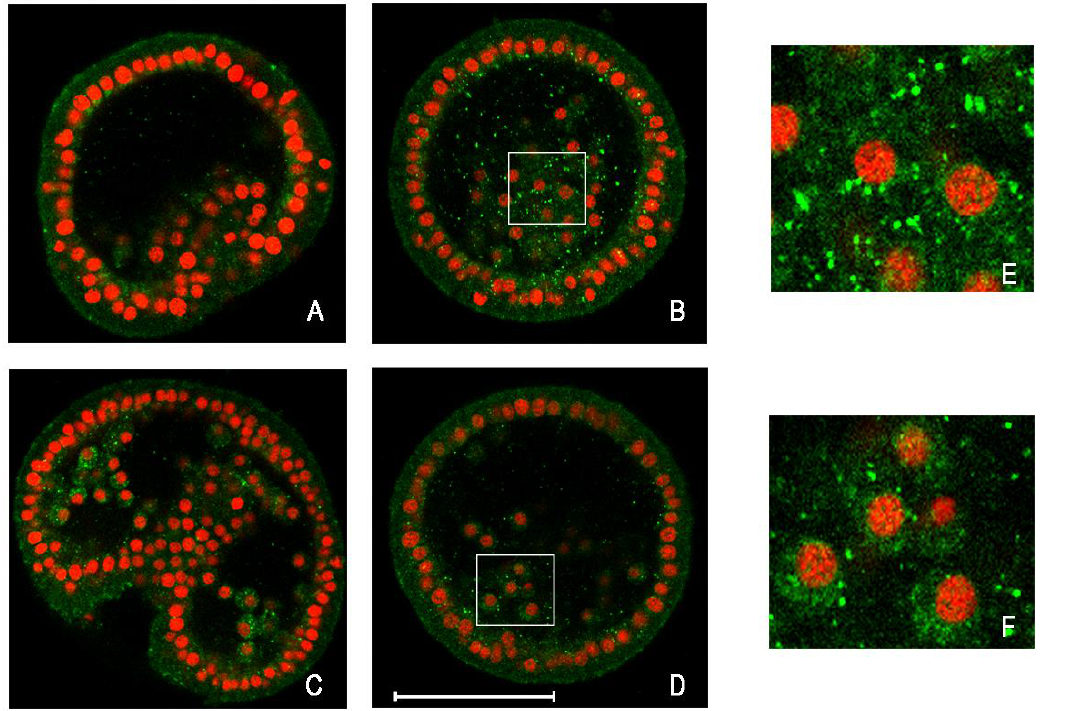
Figure 1. Detection by immunofluorescence of LC3 protein on whole-mount embryos of sea urchin. Equatorial optical sections captured by confocal laser scanning microscopy. In green, LC3 protein detection; in red, nuclei stained with propidium iodide. ( A ) Control embryo, after 18 h of growth; ( B ) Cd-treated embryo for 18 h; ( C ) Control embryo, after 24 h of growth; ( D ) Cd-treated embryo for 24 h; ( E , F ) Enlargements of a section of ( B , D ),